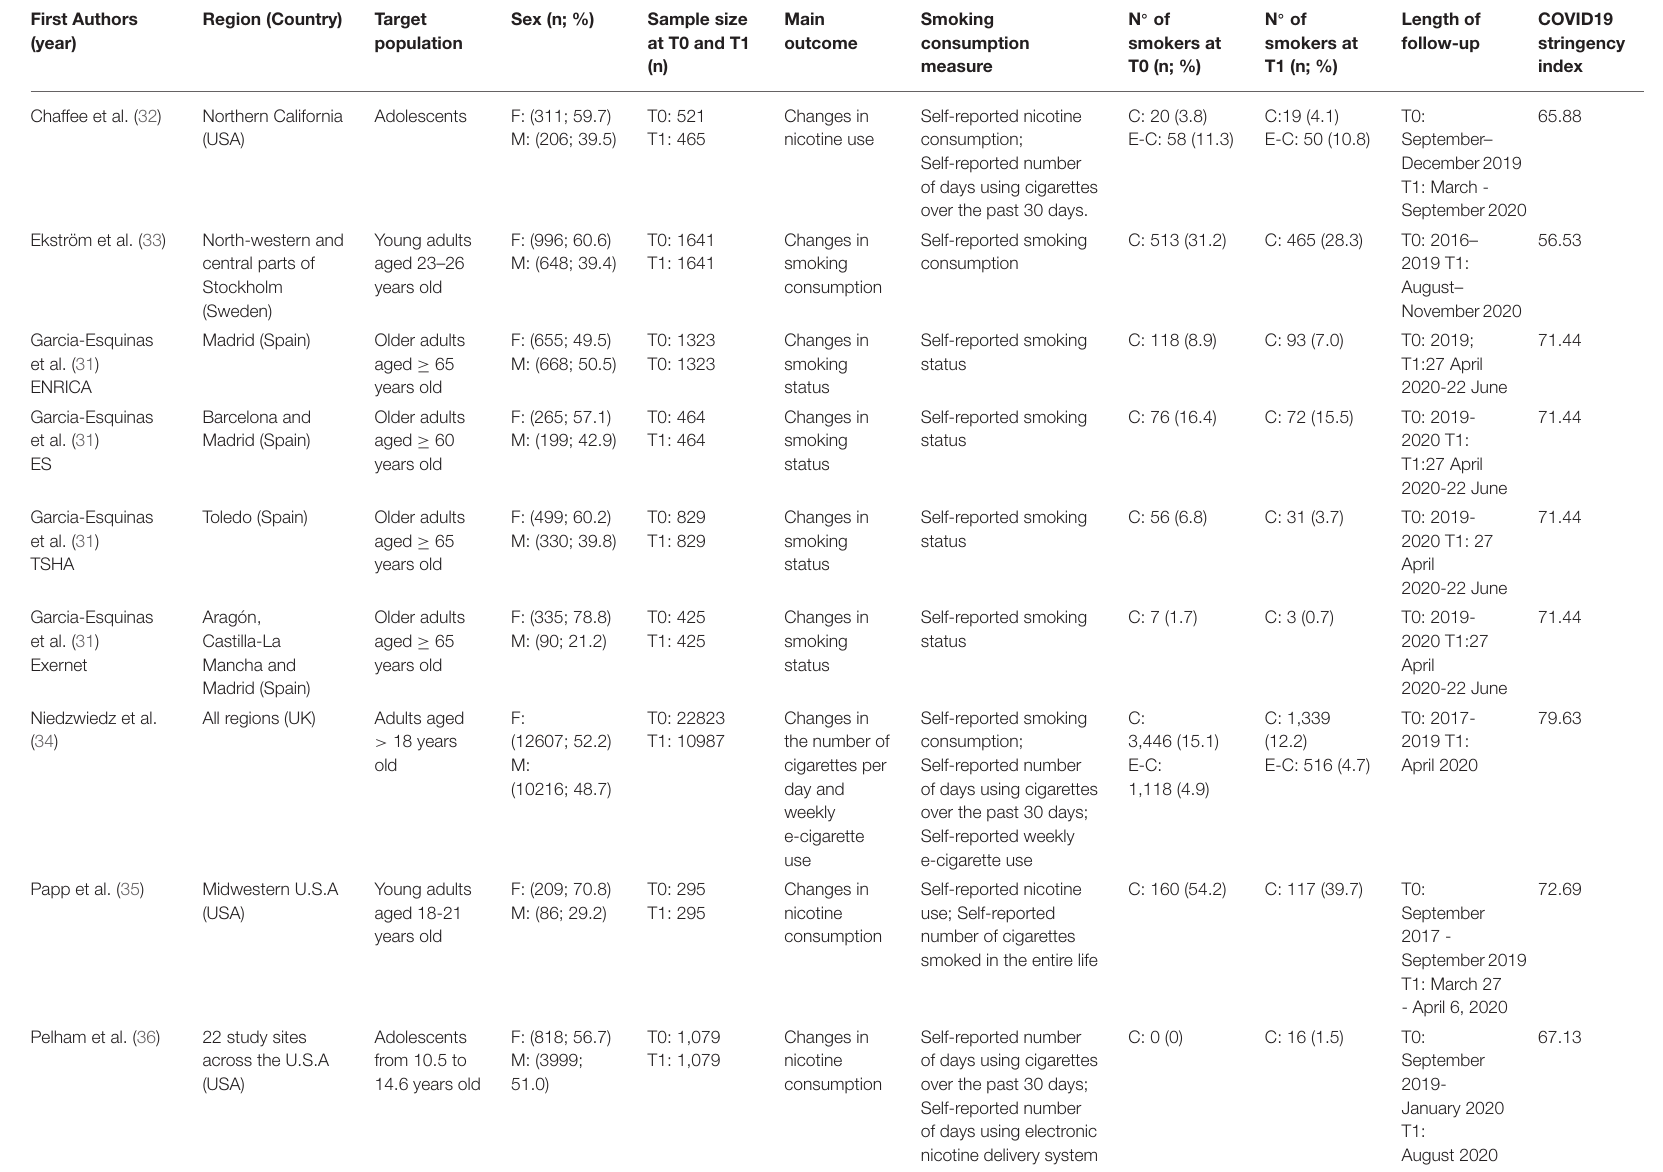
TABLE 2 | Characteristics of the studies included in the systematic